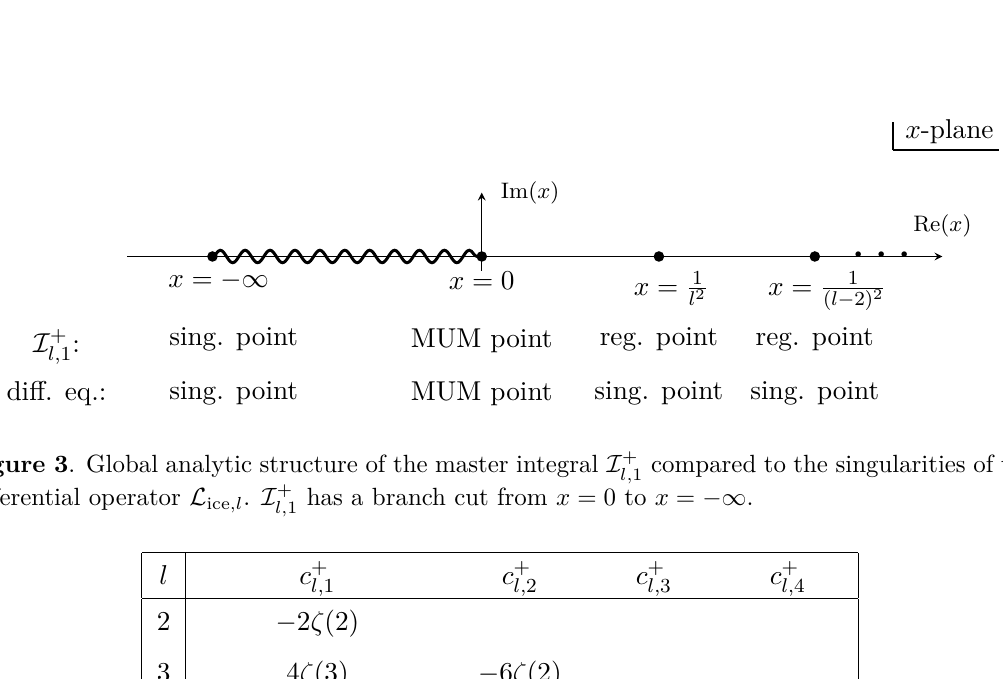
for the master integral I + l,k